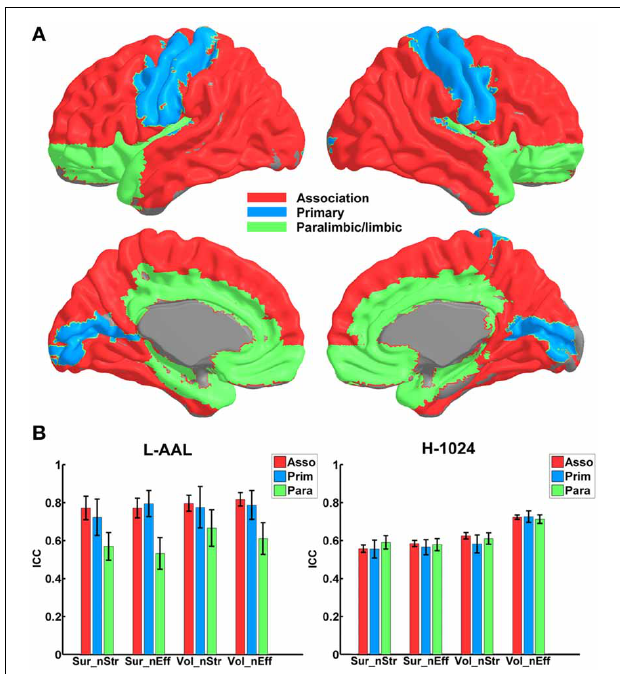
FIGURE 5 | The TRT reliability of nodal properties across different regional classes. (A) The regions are shown in red, blue and green on a 3D surface, indicating the association, primary and paralimbic/limbic cortices. (B) Statistical analysis of the nodal reliability between regional classes in the WM network. The bars and errorbars represent the mean values and standard errors, respectively, of the ICC values of all regions in each regional class. The ICCs of nodal strength and efficiency from surface- and volume-based networks were represented by Sur_nStr, Sur_nEff, Vol_nStr, and Vol_nEff, respectively.